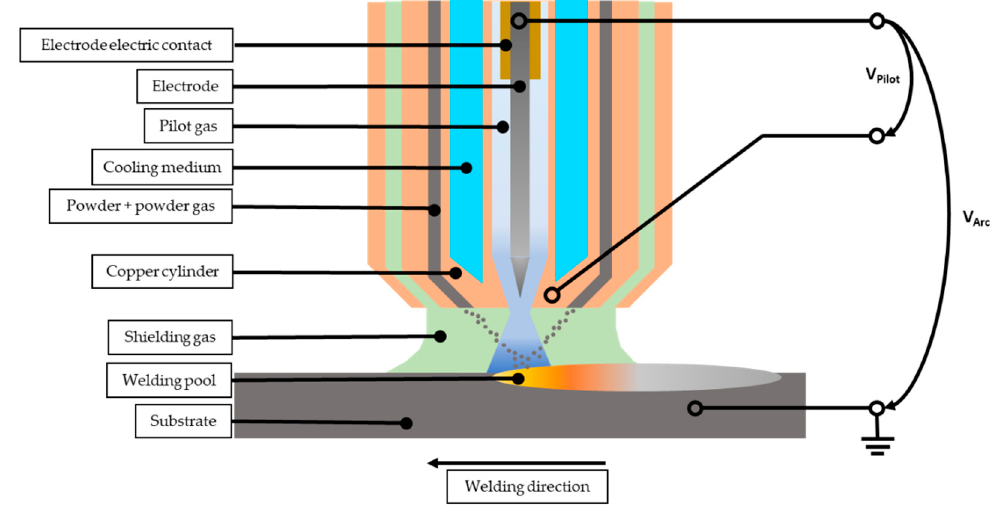
Figure 2. Scheme of the plasma transferred arc (PTA) torch.